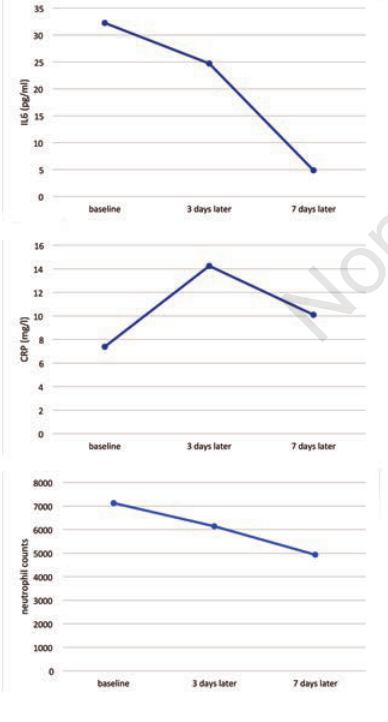
Figure 1. A) Changes level of interleukin- 6 (pg/mL) and B) C-reactive protein (mg/L) during study days; C) neutrophil counts during study